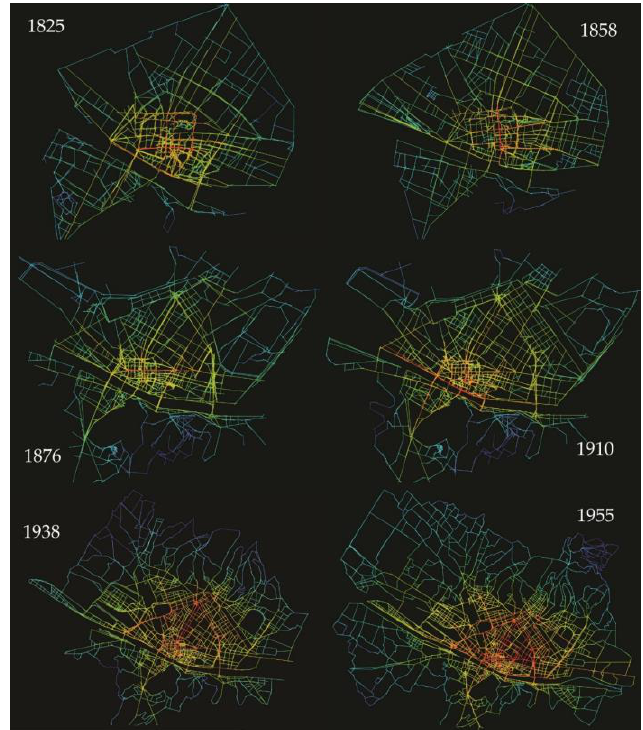
Figure 4. Distribution of global integration in Florence, 1825–1955.